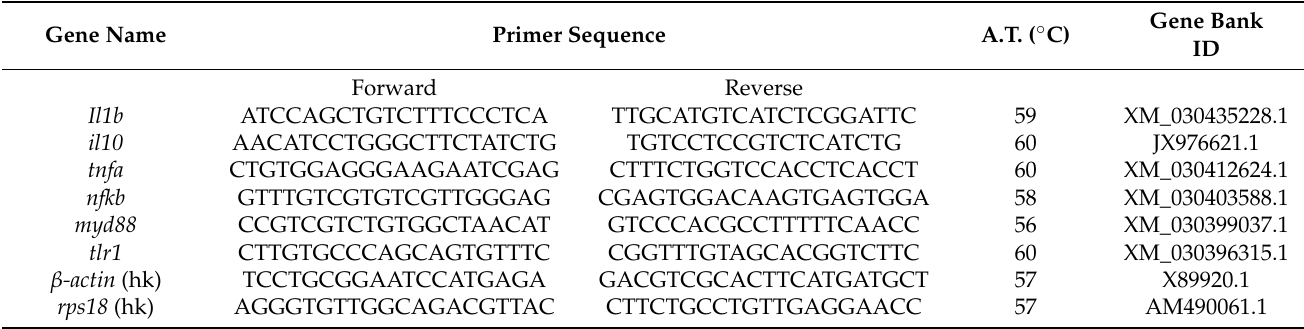
Table 3. Oligonucleotide primers, annealing temperature (A.T.), and location (Gene Bank Accession Number) of each gene investigated in this study. hk: housekeeping